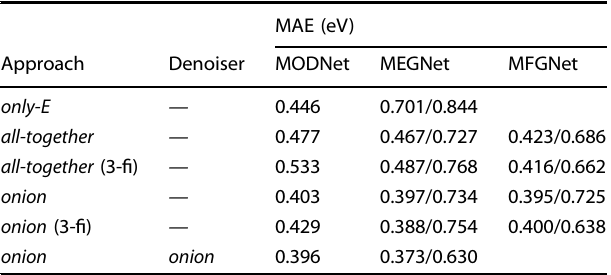
Table 2. Most representative results for the different training approaches with and without